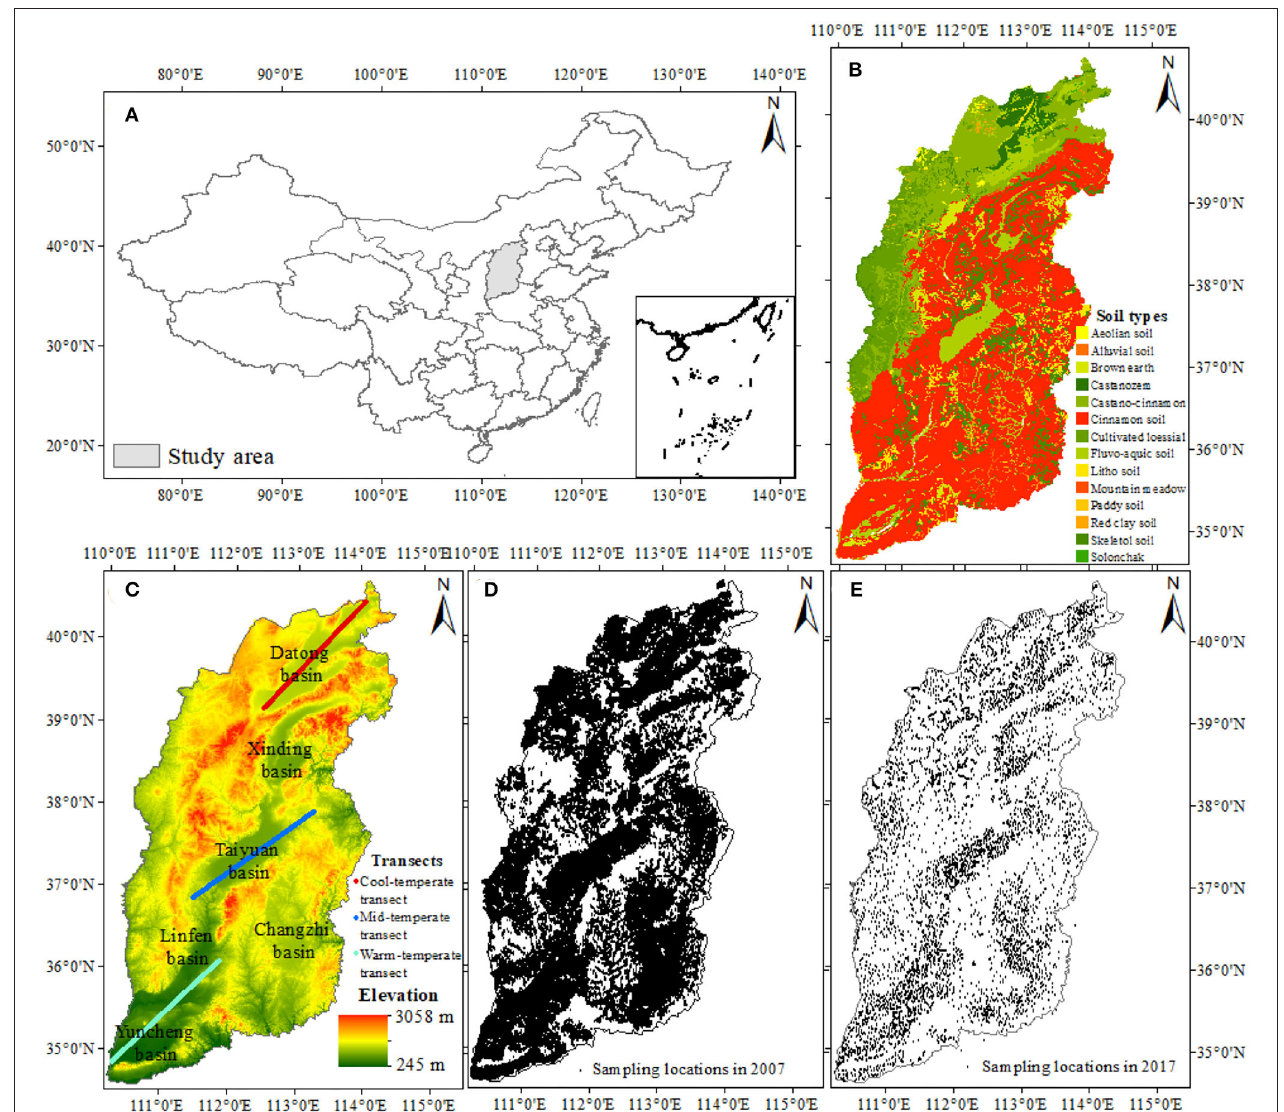
FIGURE 1 | (A) Geographic location of study area, (B) soil types, (C) digital elevation model (DEM) and sampling transects across the basins of Datong (cool-temperate transect), Taiyuan (mid-temperate transect), and Yuncheng (warm-temperate transect), (D) soil sampling locations in 2007, and (E) soil sampling locations in